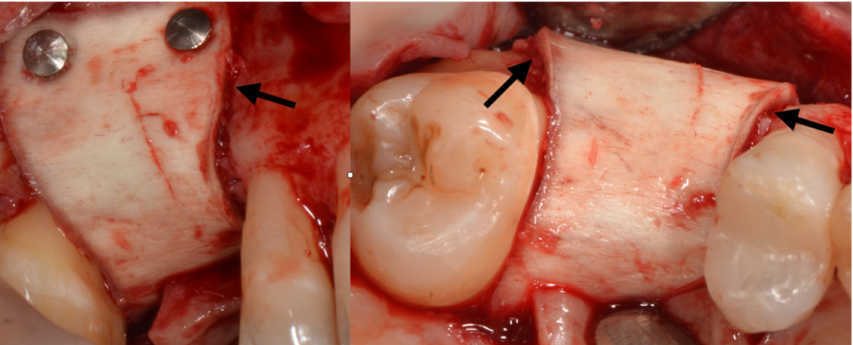
Figure 7. Bone lamina in place, arrows indicate the thickness of the lamina (1 mm) inducing both GBR and GTR effect.